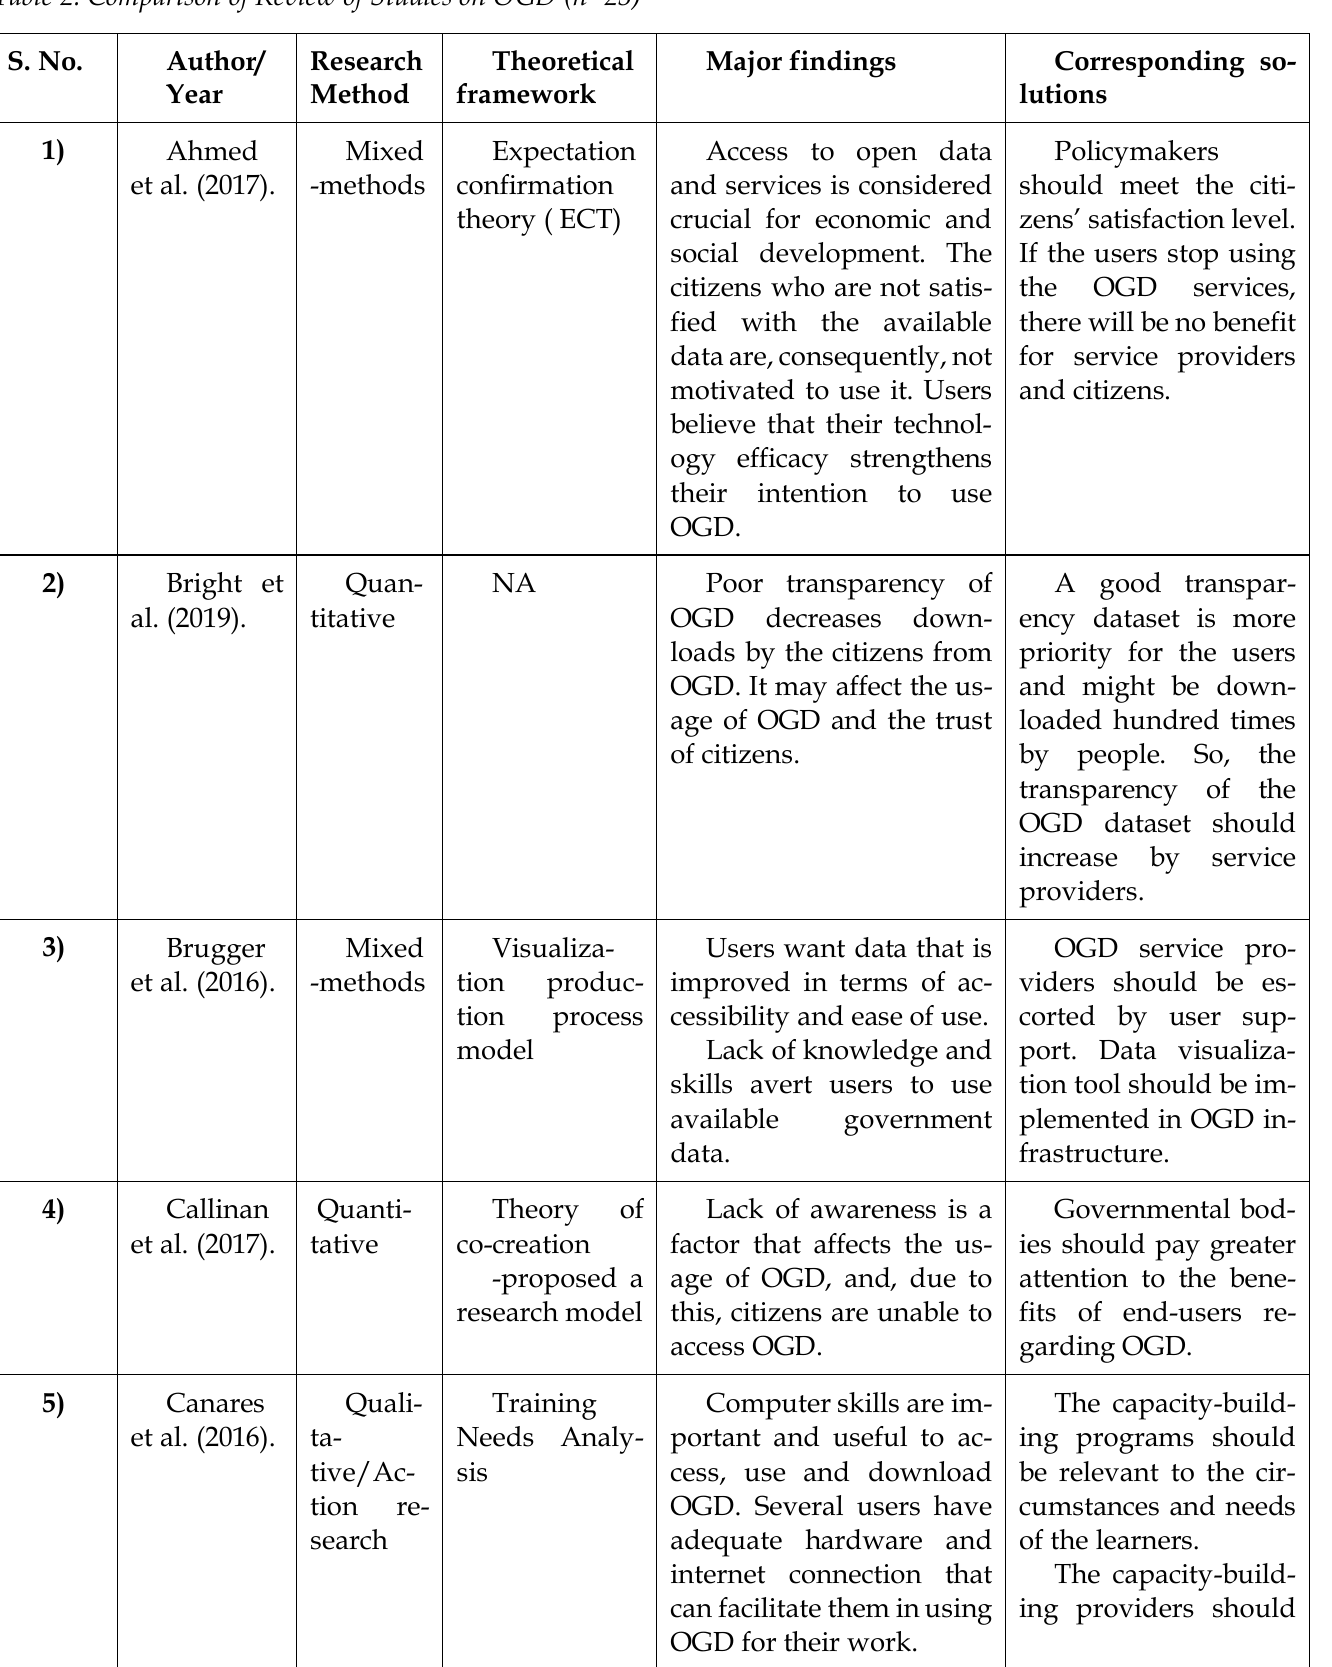
Table 2: Comparison of Review of Studies on OGD (n=23) S.